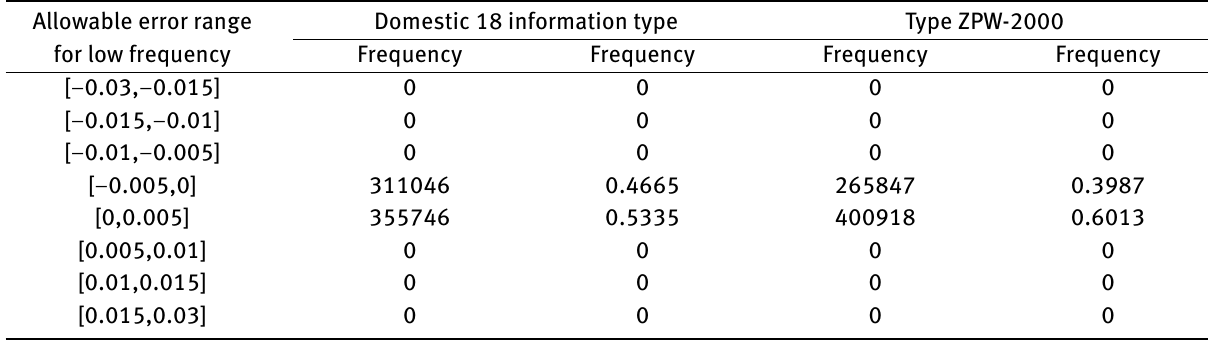
Table 3: Statistical results of 666,792 experiments of low frequency calculation error of two types of frequency shift signals Allowable error